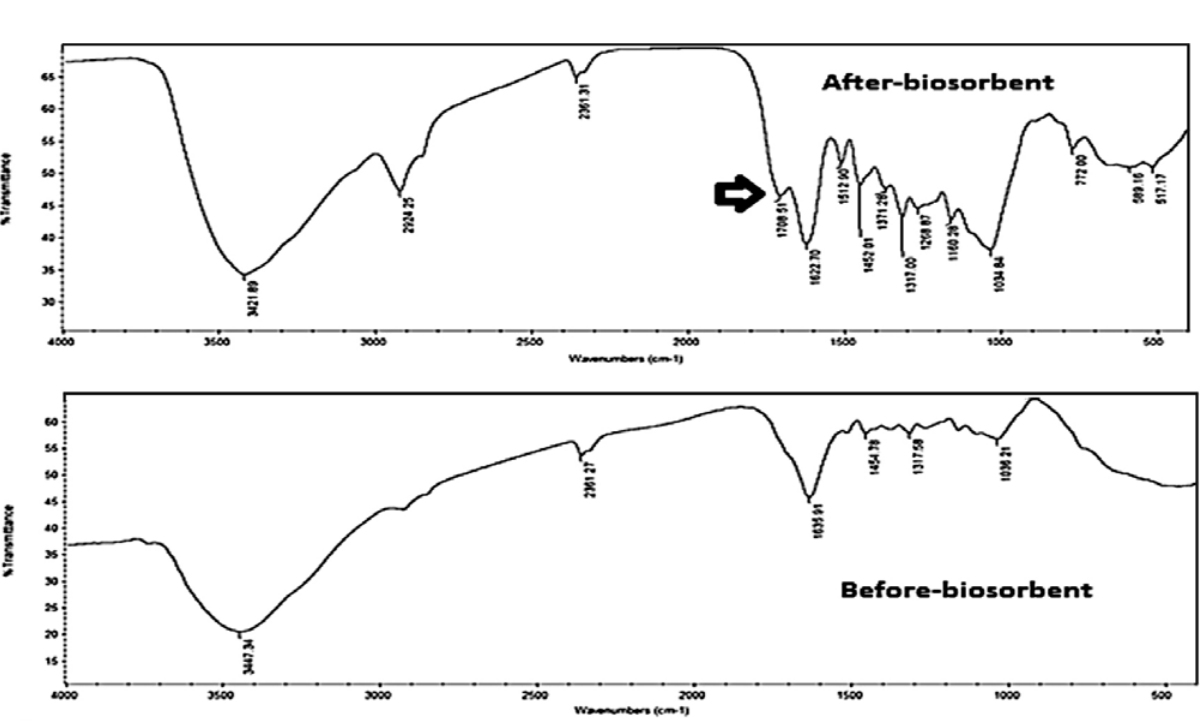
Figure 7. FTIR spectrum of biosorbent (before biosorption and after